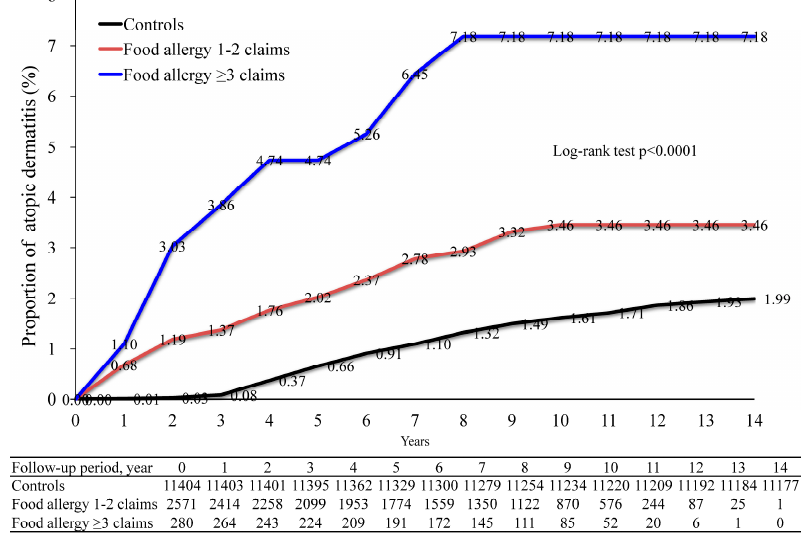
Figure 2. Cumulative incidence of atopic dermatitis in food allergy patients. The incidence of atopic dermatitis in food allergy patients and controls was compared using the log-rank test by a Kaplan–Meier analysis. Food allergy 1–2 claims versus controls, log-rank test p < 0.0001; Food allergy ≥ 3 claims versus controls, log-rank test p < 0.0001; Food allergy ≥ 3 claims versus food allergy 1–2 claims, log-rank test p = 0.0053